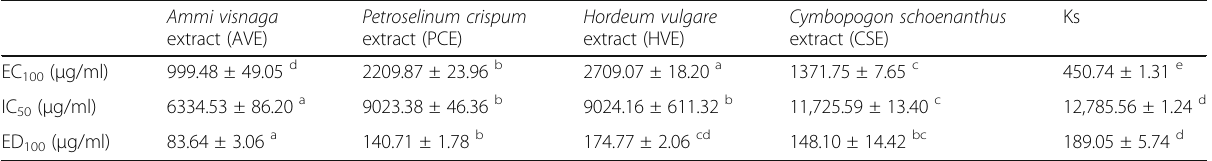
Table 2 Effect of the studied plant extracts and Ketosteril (Ks) on the viability of the untreated Vero cells and their effective doses (ED 100 ) that produced 100% therapeutic response from the carbon tetrachloride (CCl 4 )-induced nephrotoxicity Ammi visnaga extract